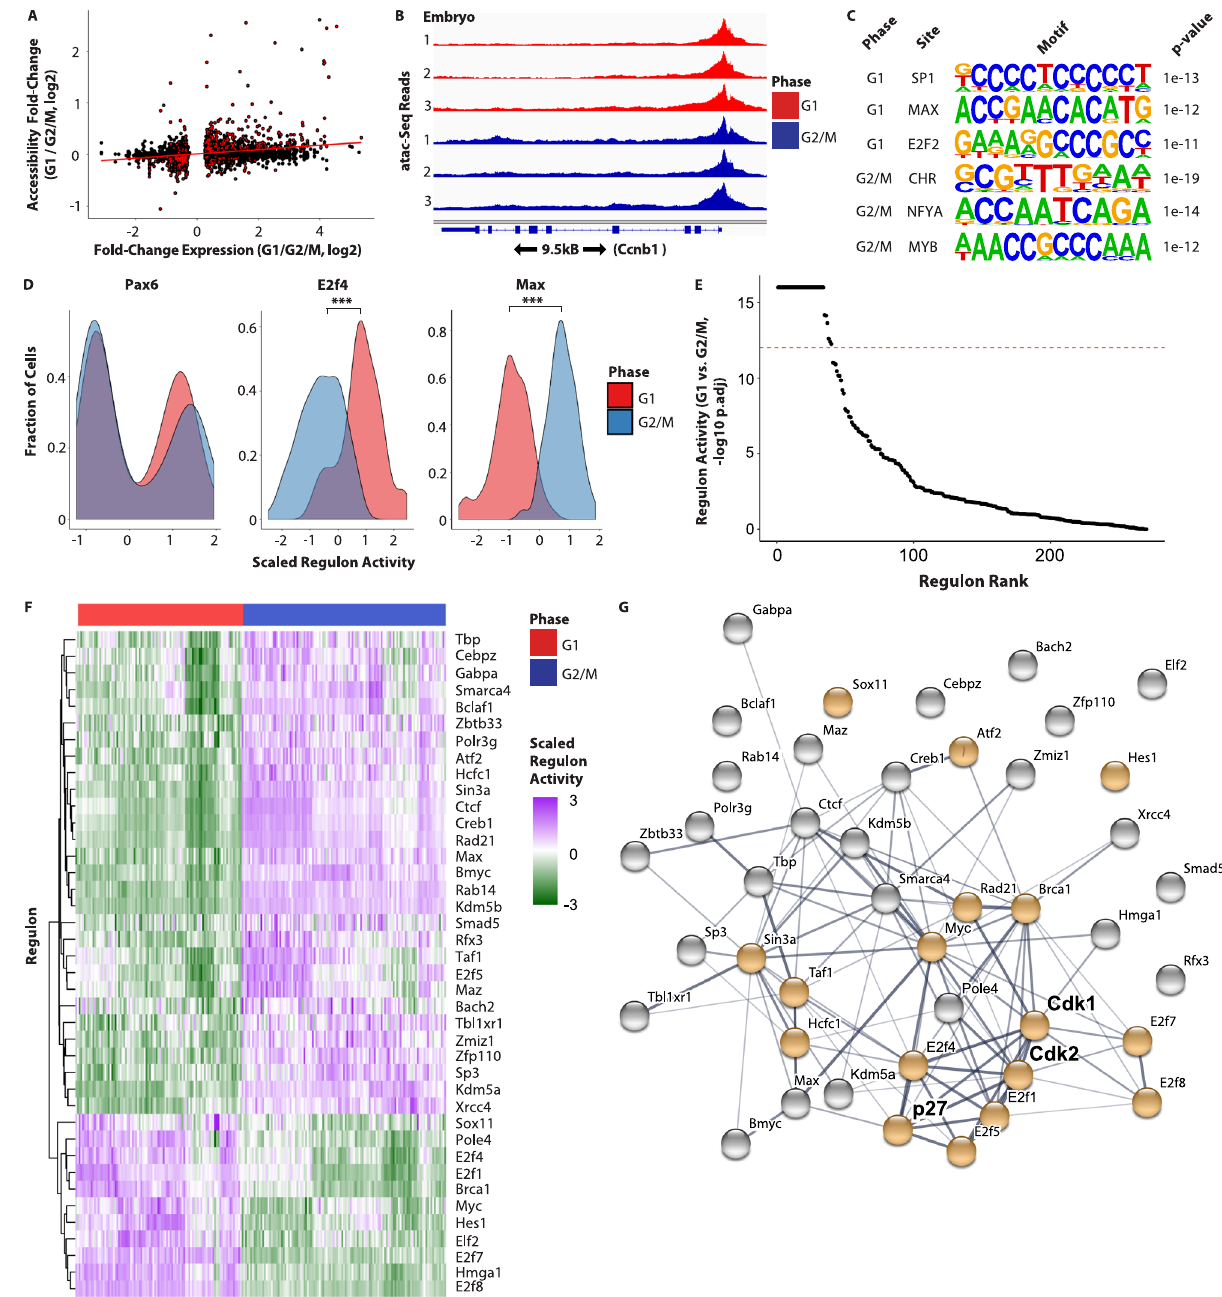
Fig. 5 Chromatin accessibility supports the network inferred to regulate phasic expression. A Correlation plot of differential accessibility as measured by ATAC-seq and differential expression between G1 and G2/M of E9.5 embryos (Spearman ’ s rho = 0.24 for all peaks associated with differentially expressed genes and rho = 0.53 for differentially accessible peaks; P < 1 × 10e − 16 in both cases). Only genes that show differential expression (adj. P < 0.05) are shown as red dots. n = 3 biologically independent embryos. B ATAC-seq tracks of three E9.5 embryos sorted into G1 and G2/M. CyclinB1 is displayed. C Motif enrichment of established regulators of phasic expression within either G1- or G2/M-associated accessible peaks. D The distribution of Pax6 , E2f4 (*** P < 0.001) and Max (*** P < 0.001) regulon activity by phase evaluated with SCENIC in all E9.5 cells (two-sided Kolmogorov – Smirnov test between G1 and G2/M). E The difference in the distribution of regulon activity between cells in G1 and G2/M. All of the regulons inferred by SCENIC among phasically expressed genes are depicted. A two-sided Kolmogorov – Smirnov test was used to evaluate the difference in activity between the phases. The threshold ( P < 1 × 10 − 12 ) used to de fi ne phase-speci fi c regulons is depicted as a red-dashed line. Source data is provided in “ Source Data.xlsx ” . F The scaled activity of each phase-speci fi c regulon (from E ) is plotted by row for each E9.5 cell (columns). G STRING plot depicting con fi dence of gene-gene interactions among phase-speci fi c regulons from wt E9.5 embryos based on the STRING database 89 . String-db builds the network based on previously annotated interactions that include co-expression and numerous experimentally determined interactions (e.g., protein – protein interactions). Increasing thickness of connecting lines represents increasing con fi dence. Included in the STRING plot are p27, CDK2, and all TFs uncovered by SCENIC (see text). Highlighted in gold are genes annotated in gene ontology “ Cell Cycle ” and “ Regulation of the Cell Cycle ” categories.